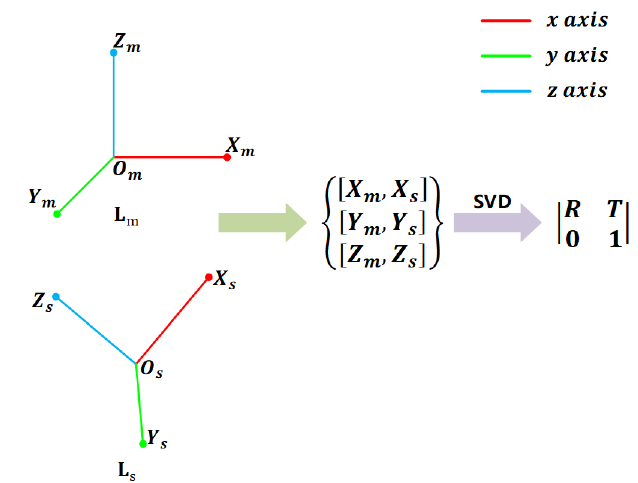
Figure 9. Illustration of directly calculating an initial pose via a single correspondence. We generate three corresponding point pairs via the centroids and LRFs of the corresponding local surface pair. The final pose is computed via SVD, which is a inner function in PCL [21].